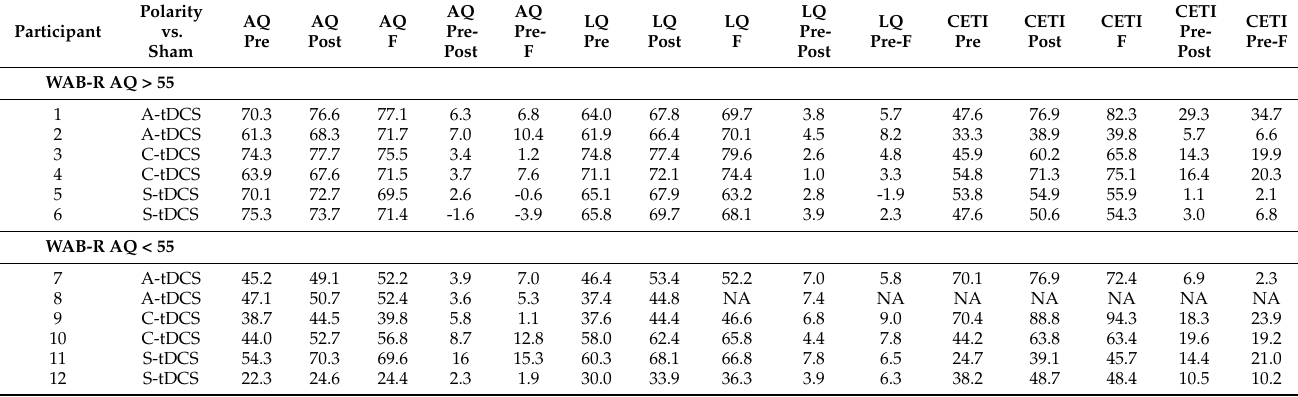
Table 4. Individual scores and gains in language performance per the WAB-R (AQ and LQ) and caregiver-reported gains on the CETI. Polarity Participant vs.